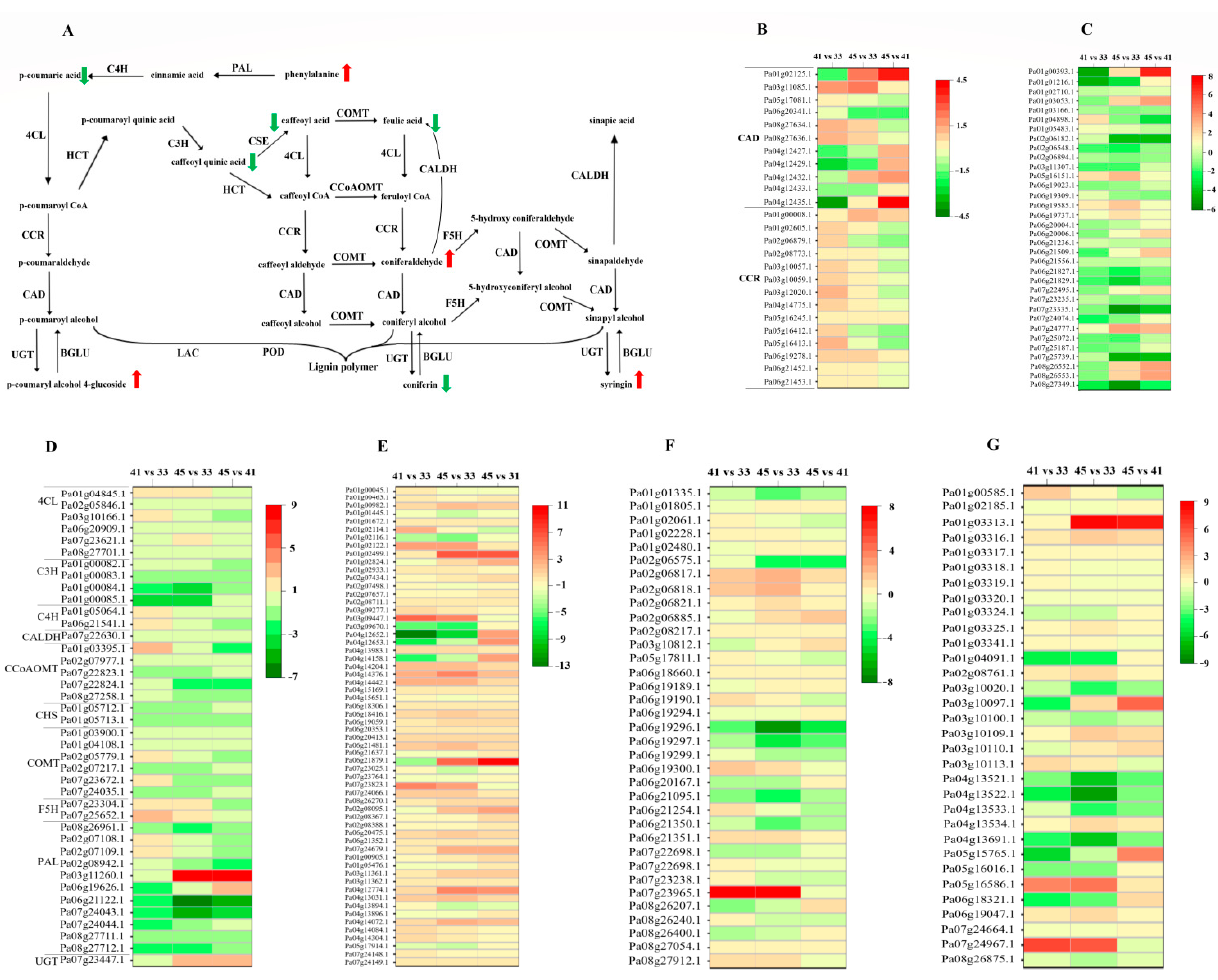
Figure 6. Lignin biosynthesis ( A ) and related gene expression ( B – G ) at the lignin deposition stages of apricot endocarp. The red arrow represents an increase in the relative content of the metabolite, while the green arrow represents a decrease in the relative content of the metabolite. ( C , E – G ) were the gene expression of POD, BGLU, LAC and POD, respectively. SK, shikimate kinase; CM, chorismate mutase; ADH, arogenate dehydrogenase; PAL, phenylalanine ammonia-lyase; C4H, cinnamate 4-hydroxylase; 4CL, 4-coumarate:CoA ligase; HCT, shikimate O-hydroxycinnamoyltransferase; C3H, p-Coumarate 3-hydroxylase; CSE, caffeoyl shikimate esterase; CcOAMT, caffeoyl-CoA O-methyltransferase; CCR, cinnamoyl-CoA reductase; F5H, ferulate 5-hydroxylase; COMT, caffeic acid O-methyltransferase; CAD, cinnamyl alcohol dehydrogenase; CALDH, coniferyl aldehyde dehydrogenase; BGLU, β -glucosidase; POD, peroxidase; LAC, laccases. Each cell represented the differentially expressed genes (DEGs) involved in the corresponding pathways. The cell color indicated the fold change of the DEGs (red means up-regulated and blue is down-regulated). The first, second and third column, respectively, represented the DEGs among 41 vs. 33 DAF, 45 vs. 33 DAF and 45 vs. 41 DAF. Different lines represent each homologous gene, which was shown in Supplementary Table S5.